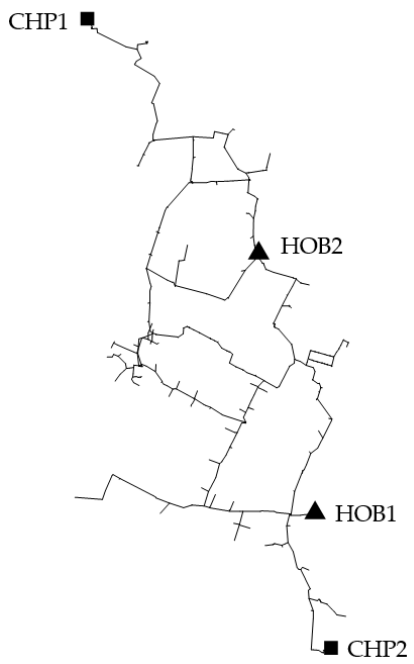
Figure 5. Schematic of the DH network topology. Only the supply transport line is